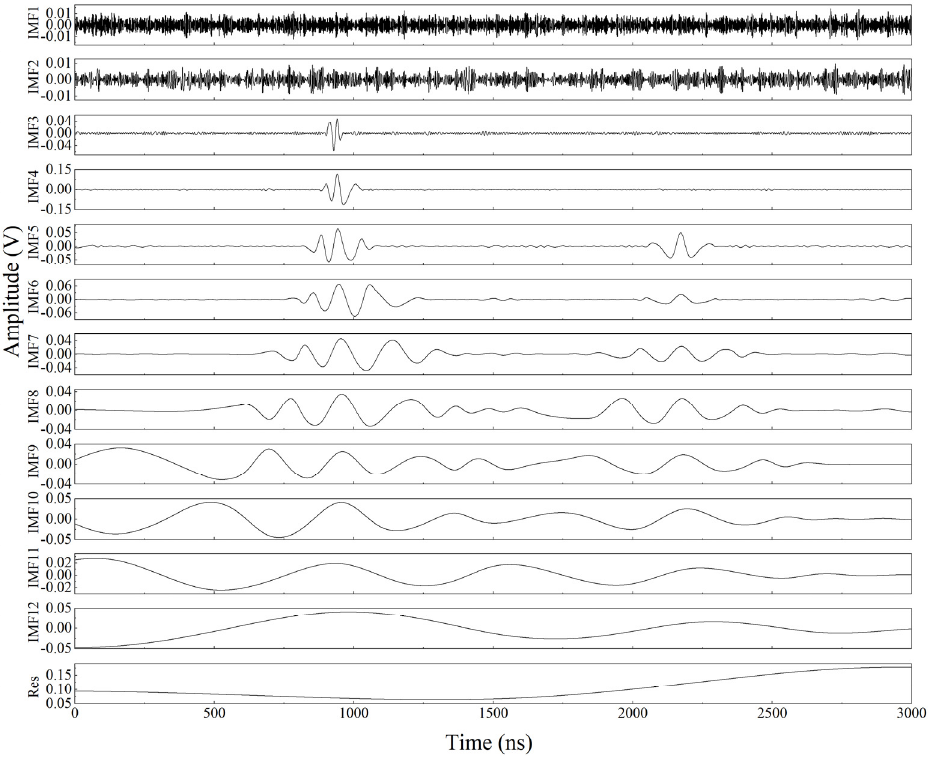
Figure 10. IMFs decomposed by the EMD method for the ultrasonic signal.